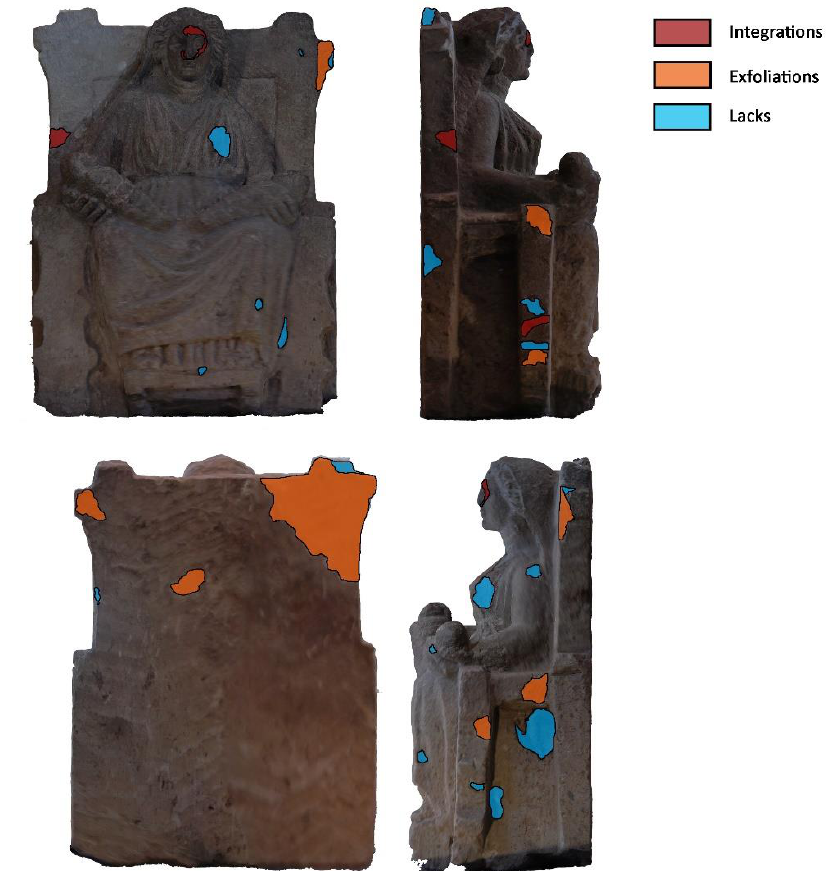
Figure 9. Analysis of degradation forms on the orthomosaics.